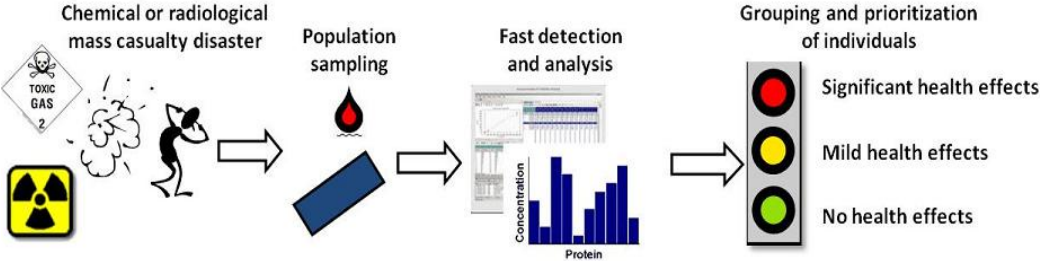
Figure 1 . Conceptual flow chart for exposure assessment of mass